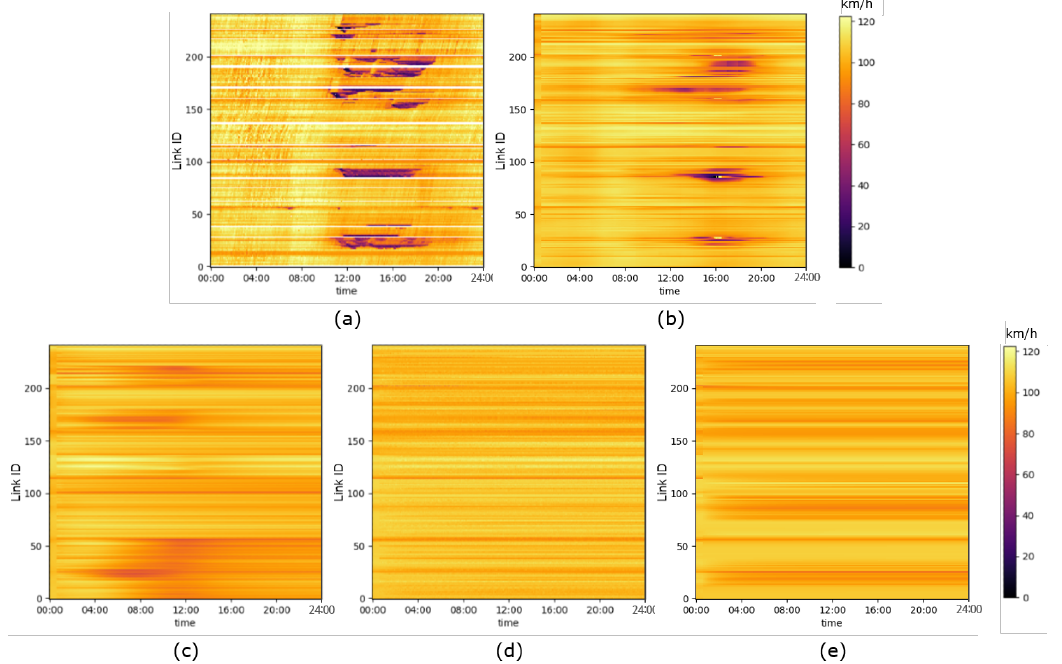
Figure 11. Speed figure of ( a ) real data, ( b ) TW-DNN, ( c ) CNN-only, ( d ) k -nn, and ( e ) ARIMA for Case